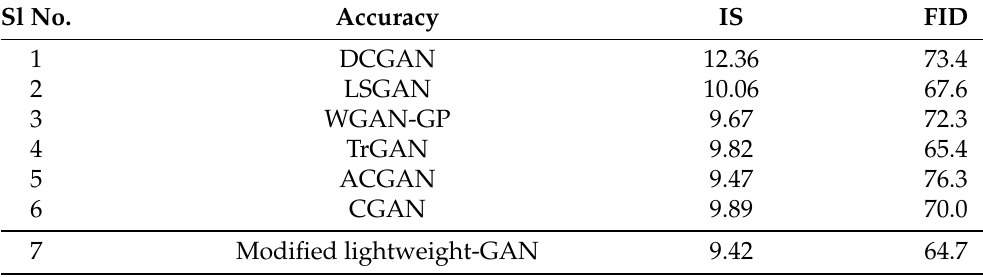
Table 3. Quantitative comparison on our dataset—inception score (IS), Frechet inception distance (FID). Sl